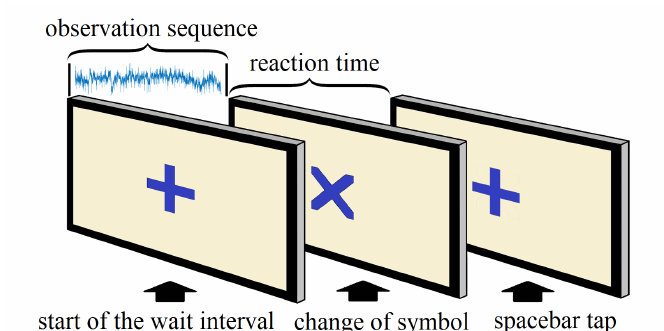
Figure 2. Sequential events for each trial.